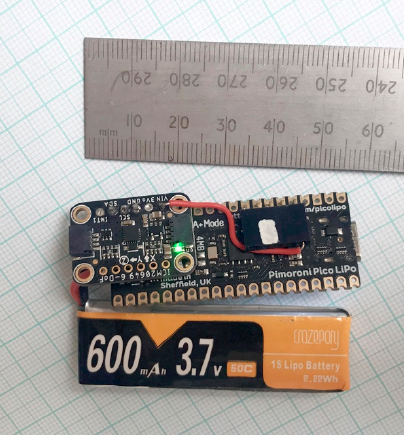
Figure 11. Photograph of microcontroller-controlled IMU.